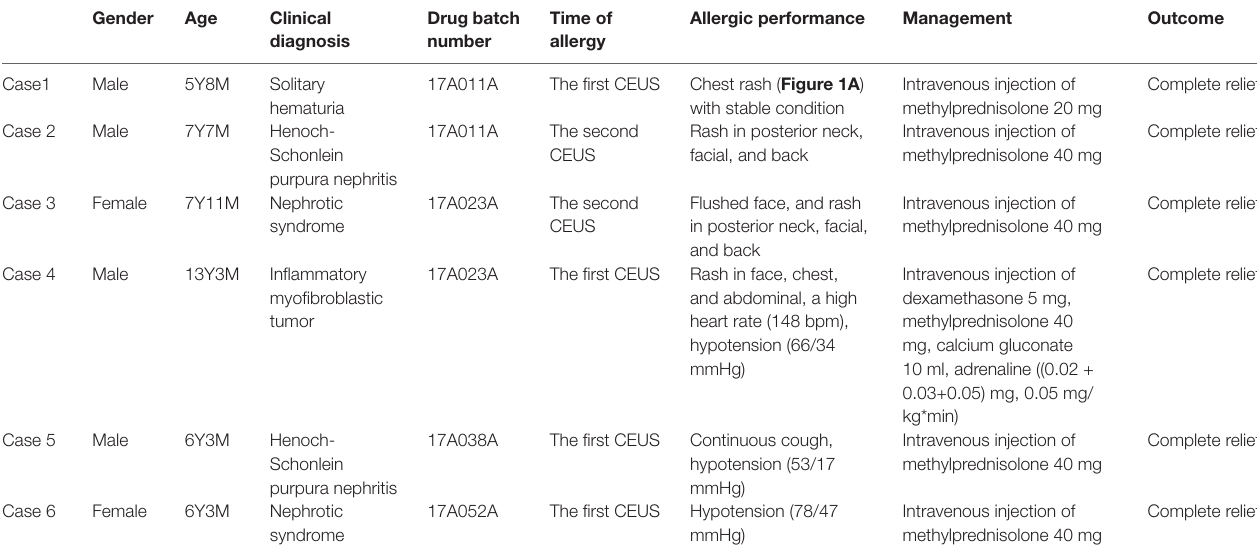
TABlE 5 | The allergies and the managements.